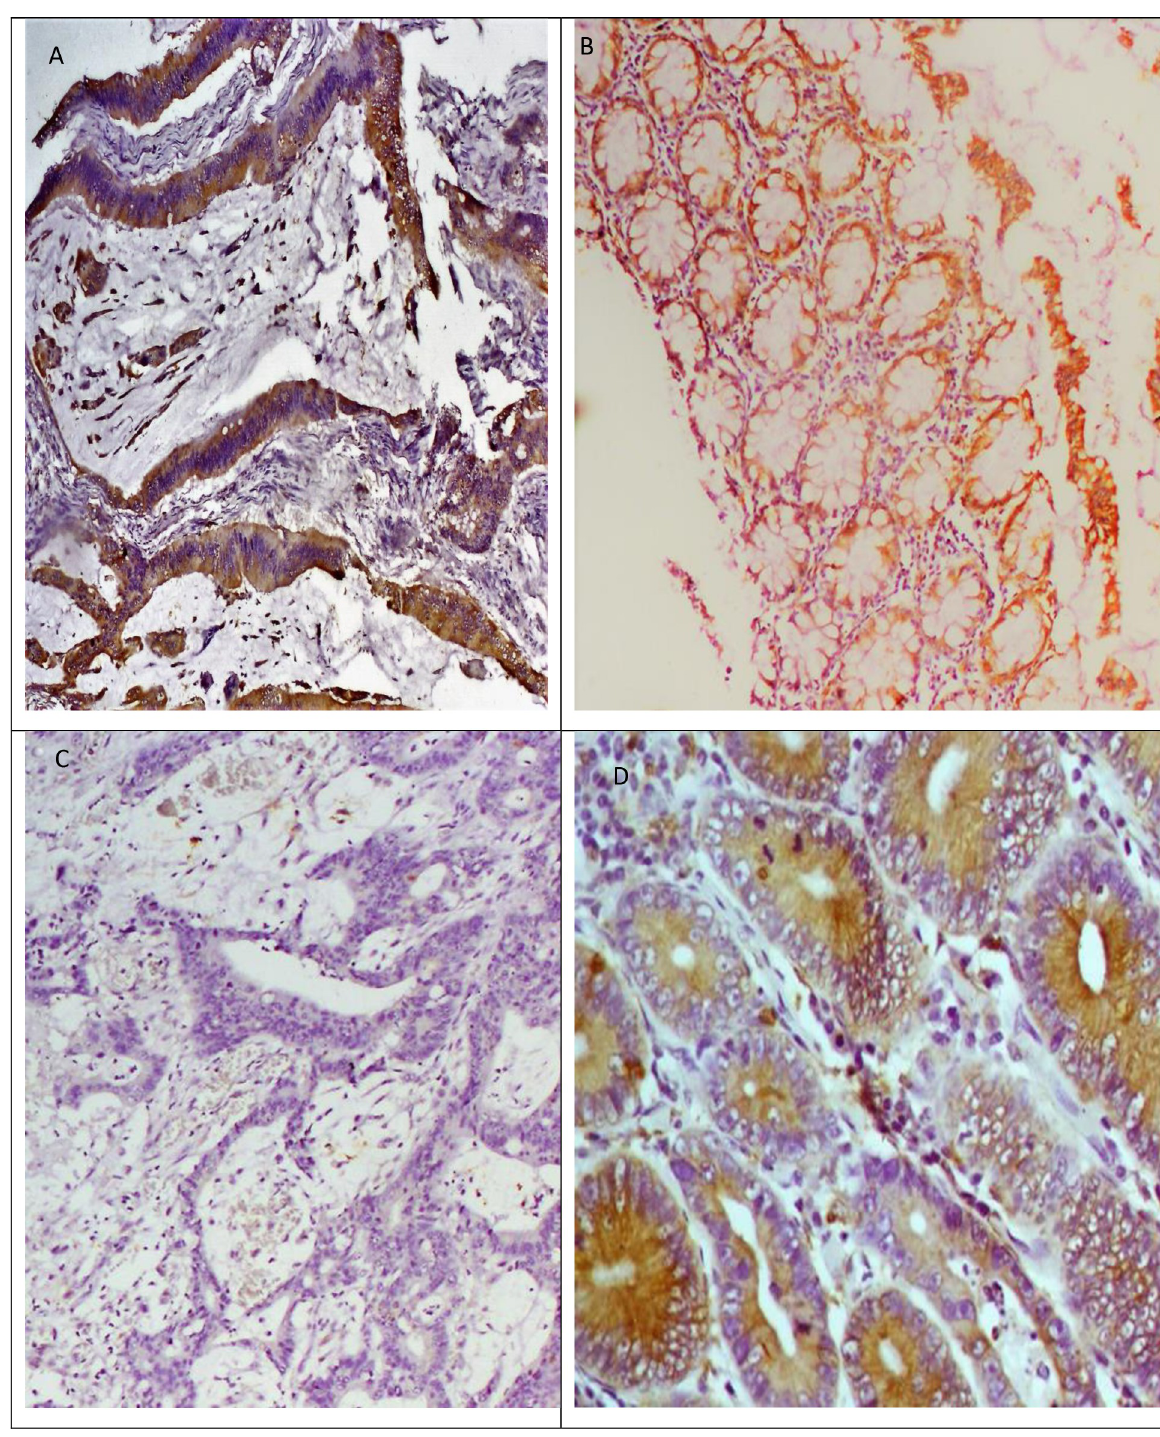
Fig 1. COX-2 immunohistochemical staining of colorectal tumour tissue, normal colonic mucosa from margin of resection and adenomatous polyps. In 1A, mucin is seen dissecting tissue planes with irregular malignant colorectal glands whose cytoplasm stain positive for COX-2 antibody. Normal colorectal tissue with positive COX-2 staining is shown in 1B. Fig 1C contains tumour tissue lacking COX-2 expression whereas that presented in Fig 1D represents COX-2 positive tubular adenomatous polyp tissue.